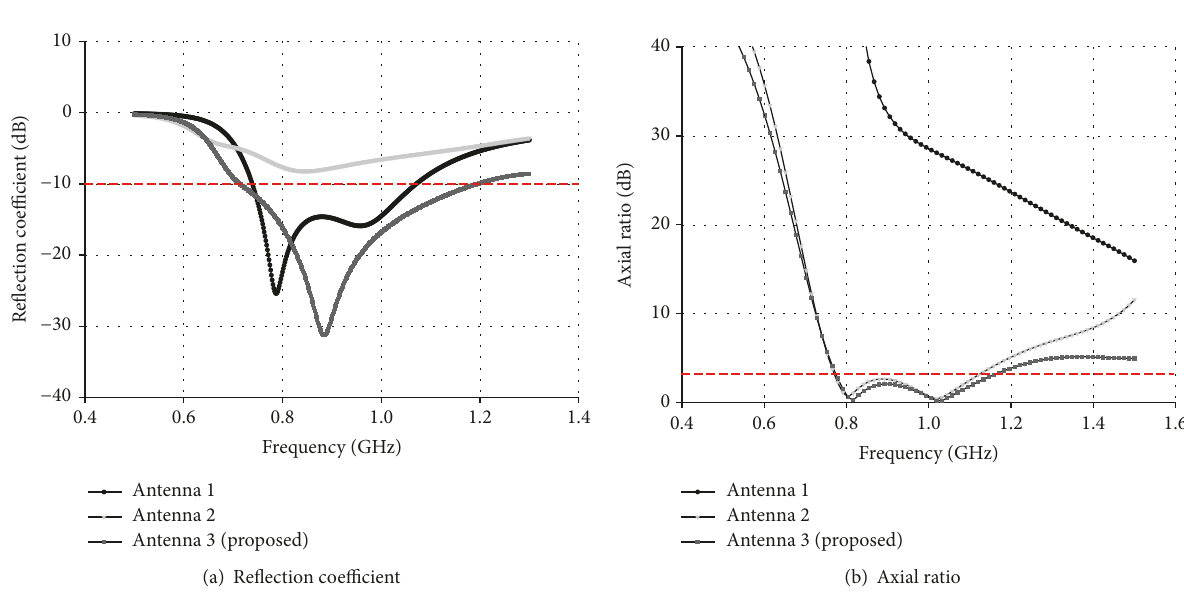
Figure 4: Simulation analysis results of the three methods.